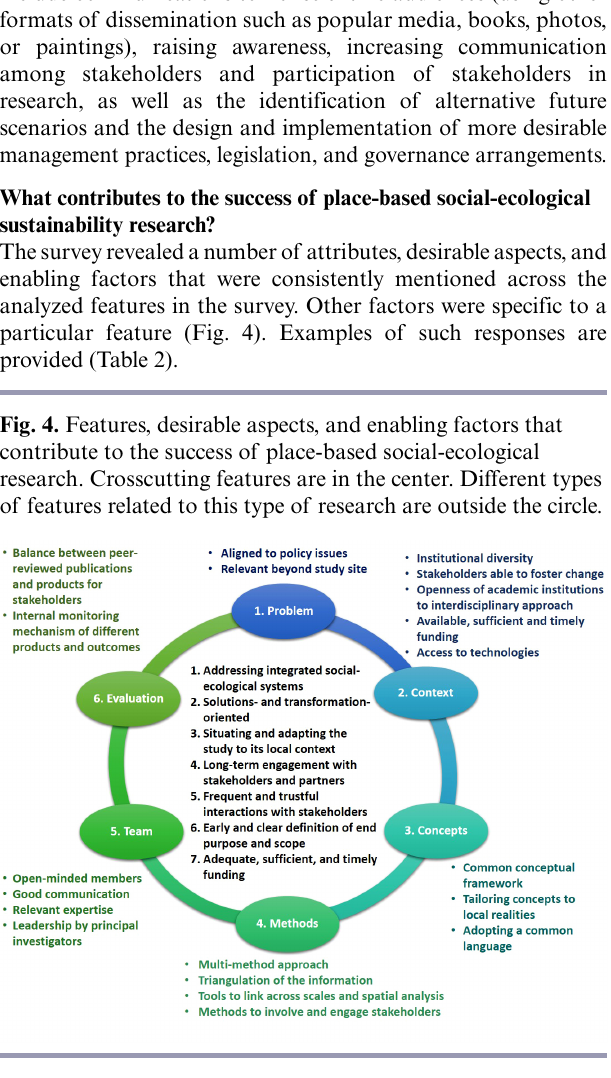
Fig. 3. Network diagram showing the 25 projects linked by